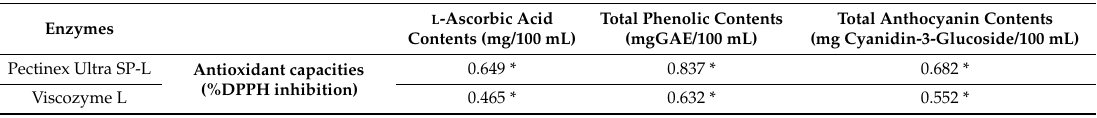
Table 1. Correlation coefficients ( r 2 ) between antioxidant capacities (% DPPH inhibition), total phenolics, total anthocyanins and ascorbic acid contents in the mulberry